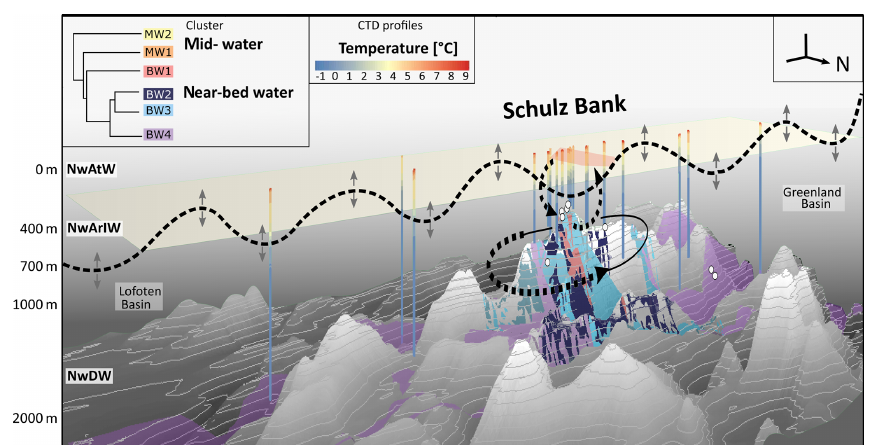
Figure 7. Conceptual overview and vertical 3D section showing spatial distribution of microbial clusters and oceanographic patterns on the Schulz Bank seamount. Extrapolated seawater microbial clusters are indicated by coloured polygons: mid-water clusters are marked in orange (MW1) and yellow (MW2), while near-bed water clusters are marked in red (BW1), dark blue (BW2), light blue (BW3), and purple (BW4). The degree of cluster similarity can be deduced from the dendrogram in the left corner of the plot. Whole water column CTD profiles are indicated, showing the measured temperature values from surface to bottom at the respective sampling locations. Sponge sampling locations visible on this side of the seamount are indicated by white balls. Vertical positions of the major water masses Norwegian Atlantic Water (NwAtW), Norwegian Arctic Intermediate Water (NwArIW), and Norwegian Deep Water (NwDW) are indicated. To give a broad orientation in space, a north arrow is depicted, and the major geologic features (Lofoten Basin and Greenland Basin). For Schulz Bank, water flows, such as a potential Taylor column circulating around the seamount, mixing between summit and pelagic realm, as well as tidally driven internal motions (black horizontal line with bidirectional arrows), are indicated by dashed arrows and